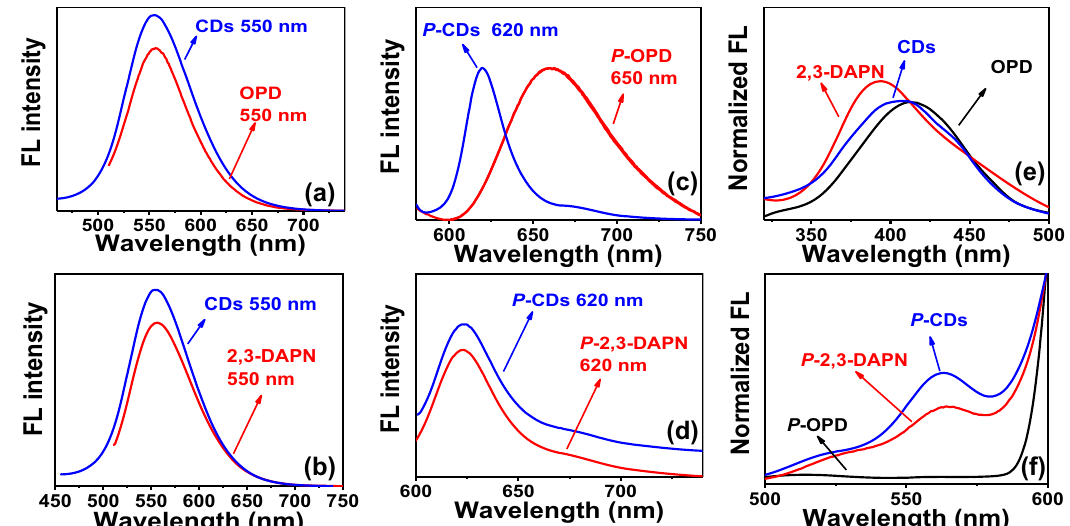
Fig. 5 PL comparison between the fl uorophore monomer and CDs. a , b FL emission of CDs, OPD, and 2,3-DAPN under the excitation of 480 nm; c , d FL emission of protonated CDs, protonated OPD, and protonated 2,3-DAPN under the excitation of 560 nm. e Excitation spectra of OPD, 2,3-DAPN, and CDs with FL emission located at 550nm; f excitation spectra of protonated CDs, OPD, and 2,3-DAPN featuring FL emission at 620 nm. (P-CDs: CDs with protonation treatment, P-OPD, and P-2,3-DAPN: OPD and 2,3-DAPN molecular at pH 1